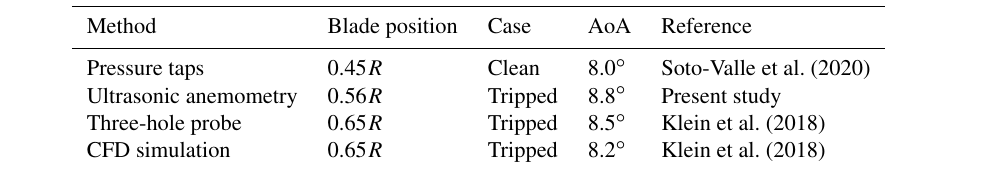
Table 4. Comparison of approximate AoA results at rated conditions and ϕ = 270 ◦ .